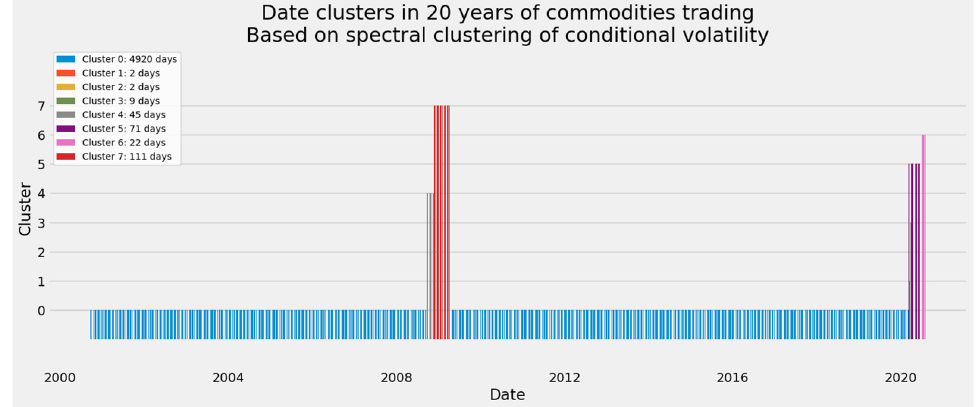
Figure 7. Spectral clustering of commodity markets—An ordered